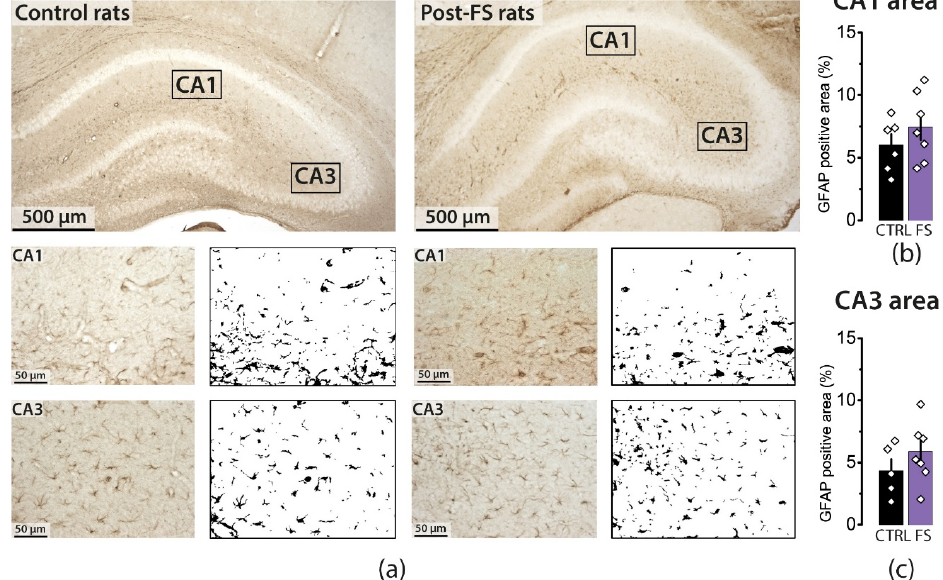
Figure 3. Animals at P12 after FSs showed no change in the area occupied by GFAP ‐ positive objects. ( a ) Representative images of hippocampal sections (×5 magnification) and images of the stratum radiatum of the CA1 and CA3 fields (×40 magnification) and their black ‐ and ‐ white masks, which were obtained in the ImageJ program and used to count the area occupied by GFAP ‐ positive objects. The averaged area occupied by GFAP ‐ positive objects in the stratum radiatum of the CA1 ( b ) and CA3 ( c ) fields. The diamonds show the individual values for each rat. However, in P21 animals exposed to FSs, the area occupied by GFAP ‐ positive objects was significantly less than in the control group (Figure 4; CA1: control—9.0 ± 0.9%, N = 6, FS—6.0 ± 0.8%, N = 7, t = 2.52, p < 0.05; CA3: control—7.5 ± 0.9%, N = 6, FS—4.3 ± 0.6%, N = 7, t = 2.98, p < 0.05). Moreover, GFAP ‐ positive astrocytes had rather short branches, and their morphological characteristics resembled those of rats at 11 days of age.